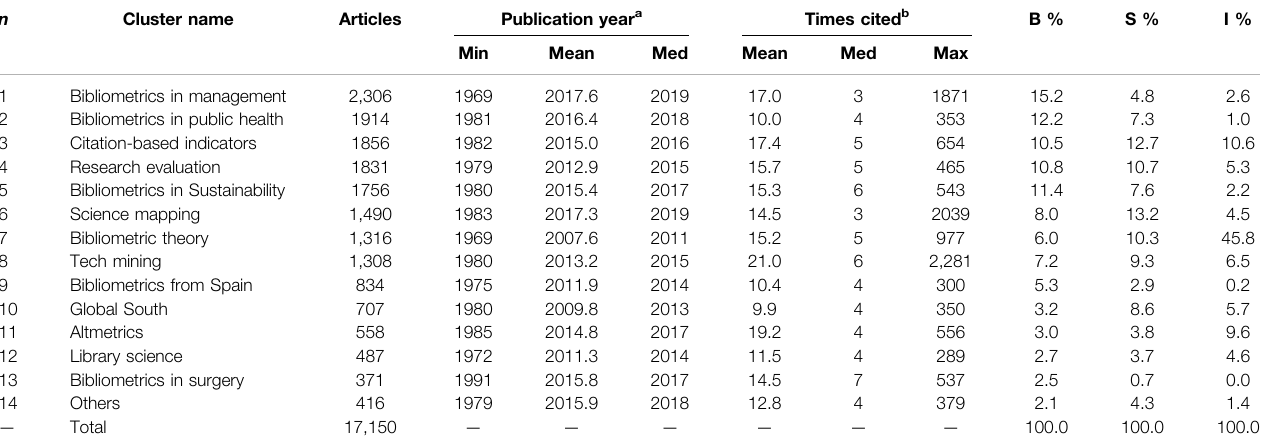
TABLE 1 | Summary of clusters in the citation network including the share of articles containing the terms bibliometrics (B), scientometrics (S), and informetrics (I).